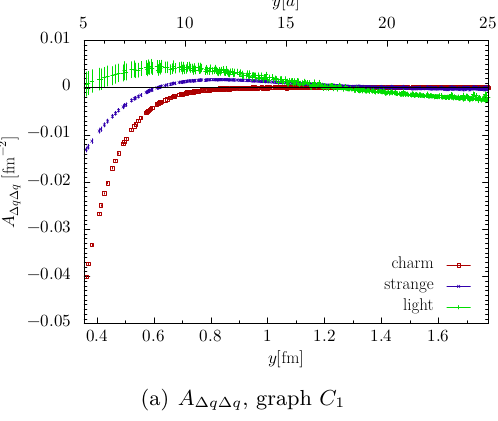
Figure 18 . As figure 17, for A ∆ q ∆ q and with a linear instead of a logarithmic